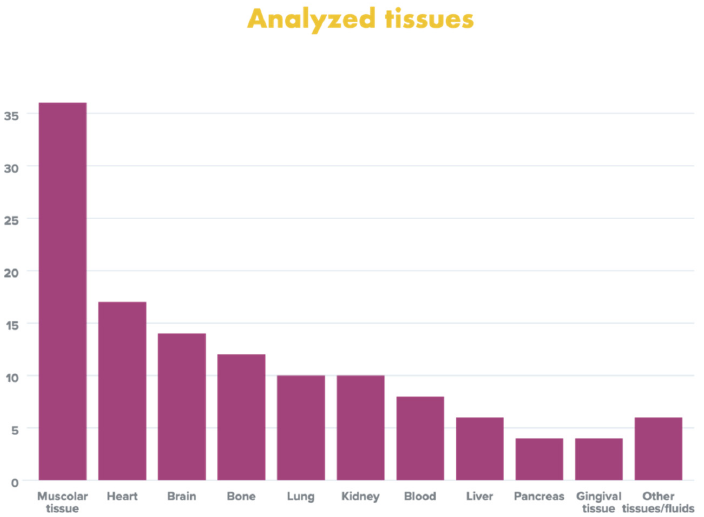
Figure 2. Overall frequency of tissue analysis examined in the studies selected for review (%). The PMI included the analysis of the early PMI (0–24 h) in 27/47 studies (80.8%), analysis of the SME intermediary (1 day–1 month) in 38/47 studies (57.4%) and analysis